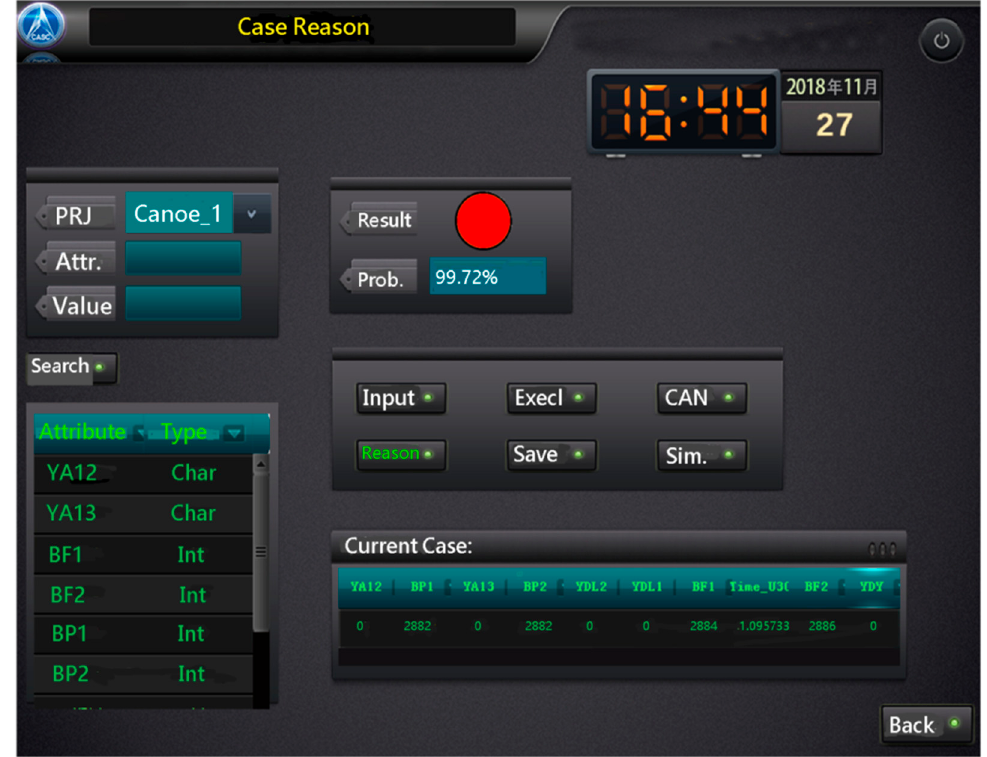
Figure 6. A snapshot of the CBR process.